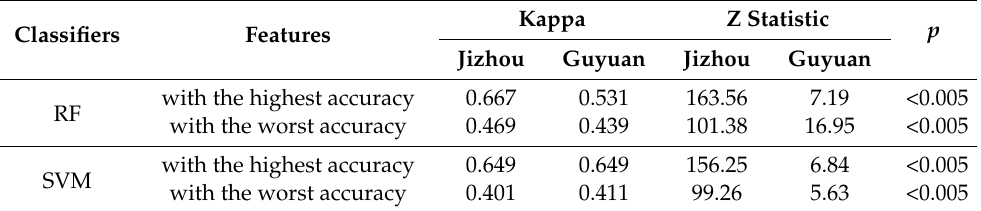
Table 5. Z test values for testing the significance of mapping PMF in Jizhou and Guyuan.